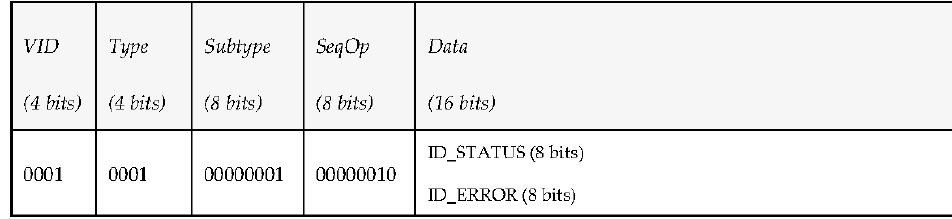
Figure 15. Appearance of the PDU used as an answer for periodic mission status data.